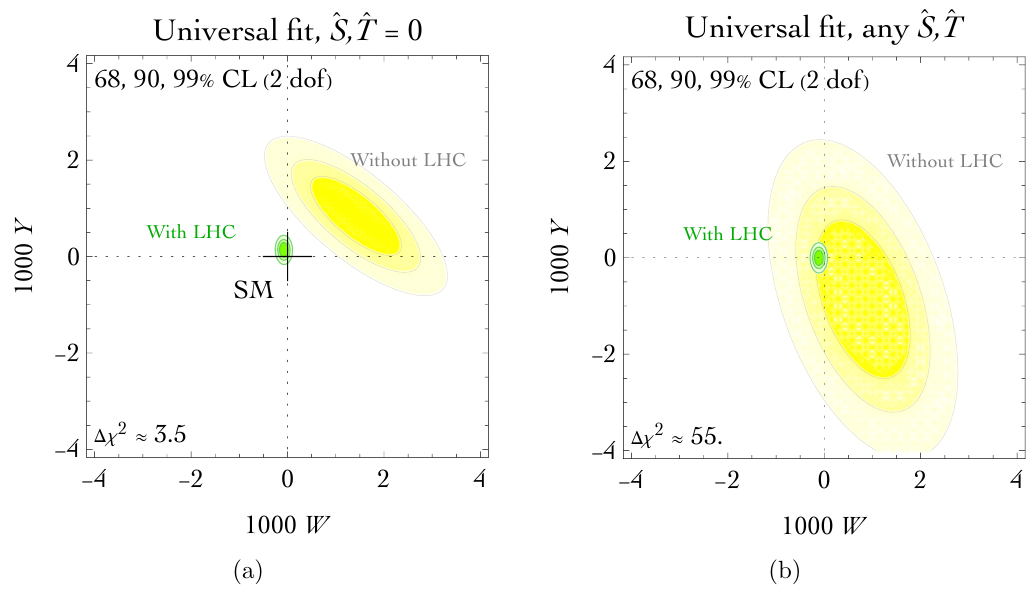
Figure 3. Global fit of the universal W and Y electroweak parameters. Regions as in figure 2.